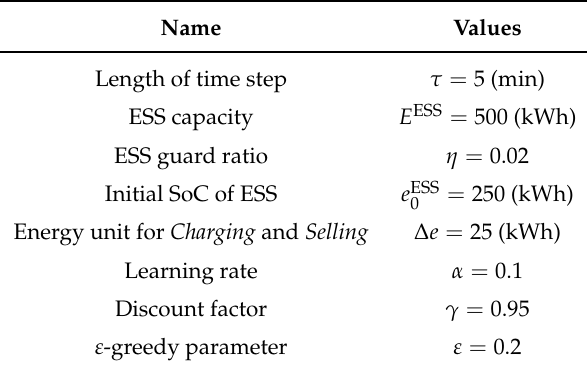
Table 1. Simulation input